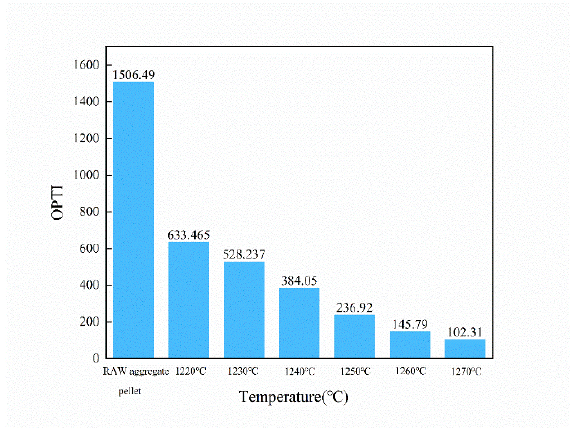
Figure 10. The OPTI of the ceramsites at different sintering temperatures.